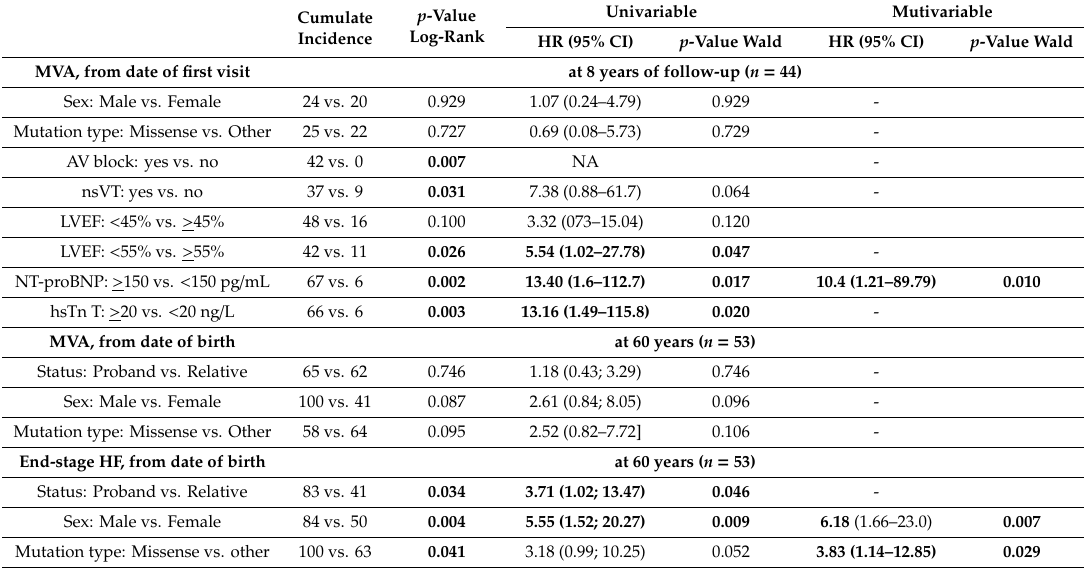
Univariable Mutivariable p -Value Cumulate Log-Rank Incidence HR (95% CI) p -Value